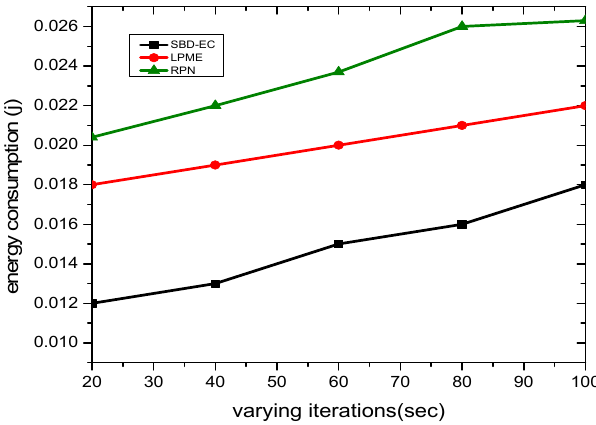
Figure 3. Energy consumption and iterations.